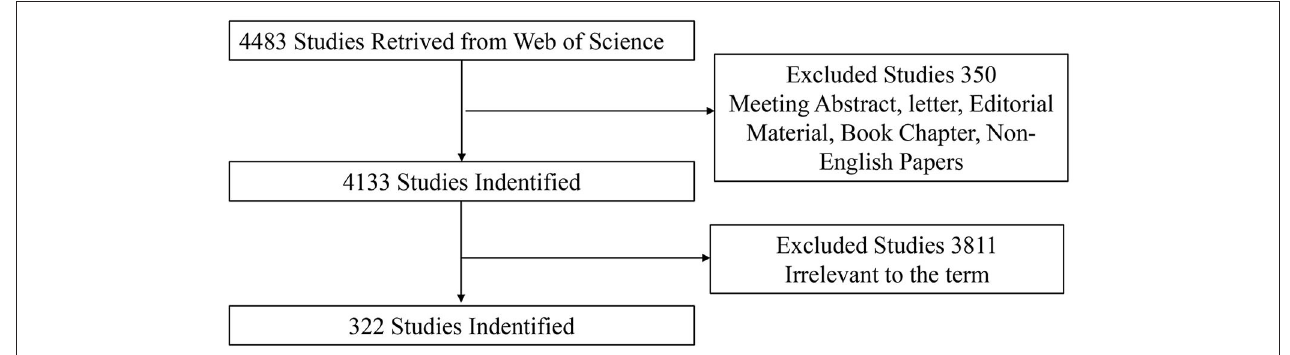
FIGURE 1 | Flowchart of studies